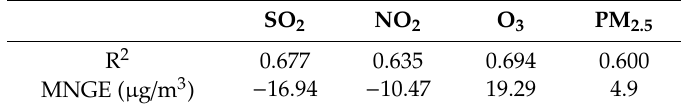
Table 2. Results of air quality model validation for SO 2 , NO 2 , O 3 , and PM 2.5 . SO